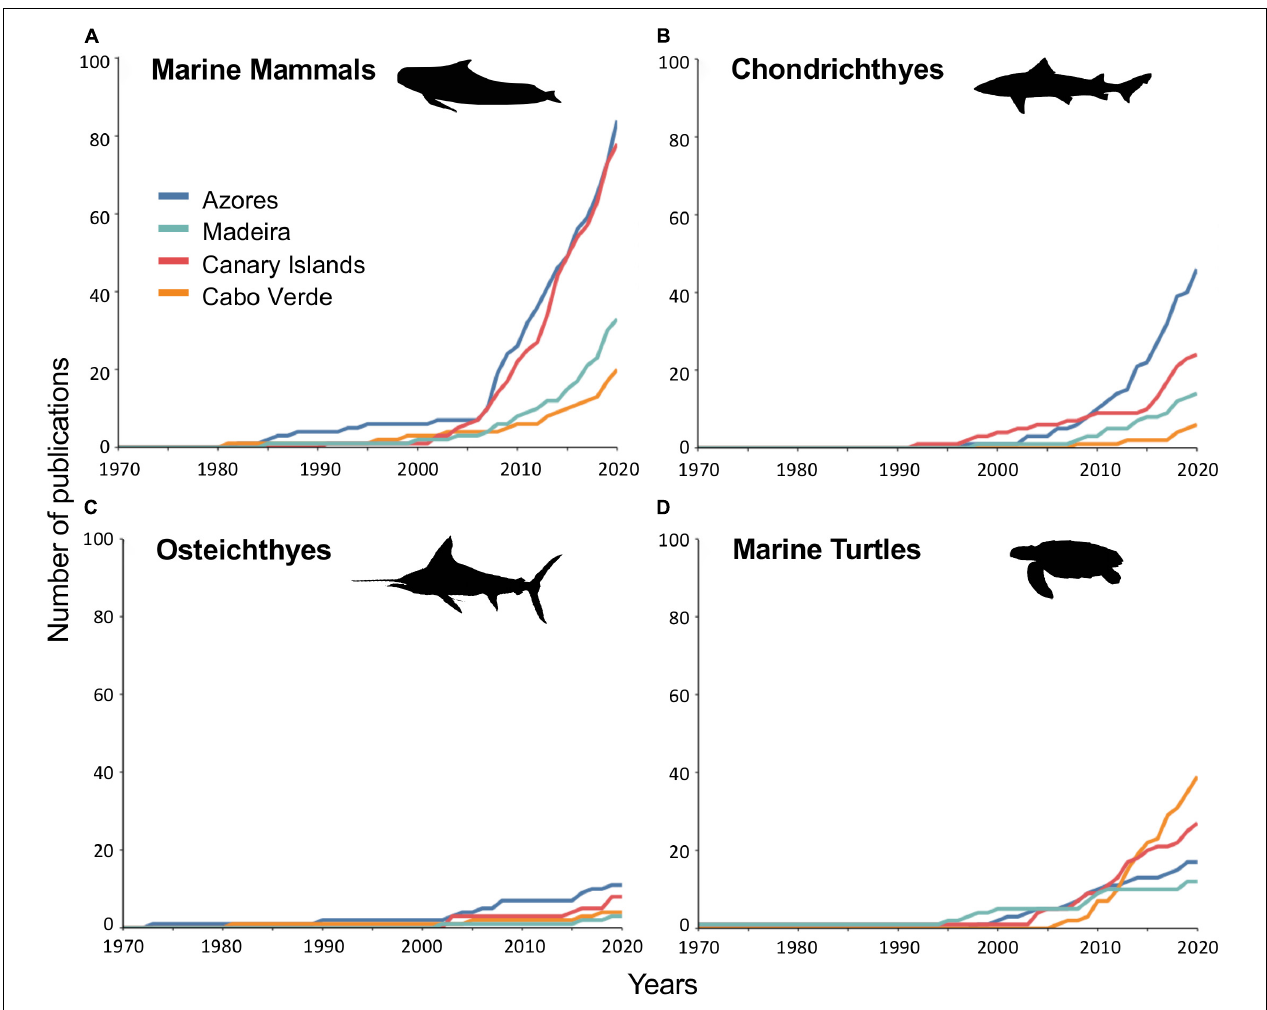
FIGURE 3 | Cumulative number of publications in marine megafauna research per archipelago through time: (A) marine mammals, (B) chondrichthyes, (C) large-bodied osteichthyes, and (D) marine turtles. Silhouettes derived from Phylopic